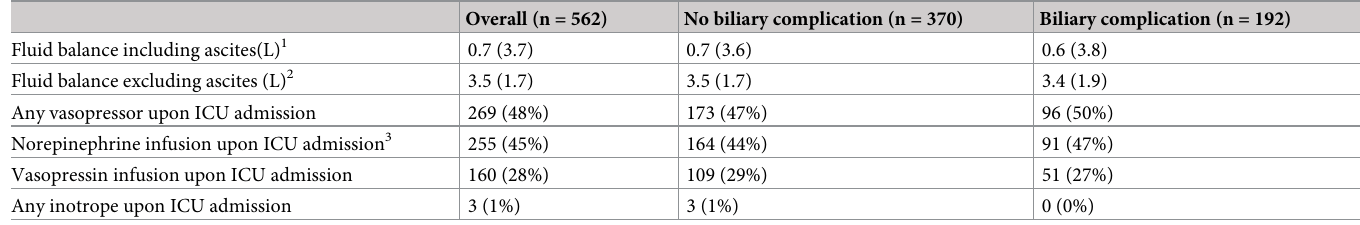
Table 3. Fluid balance and vasopressor